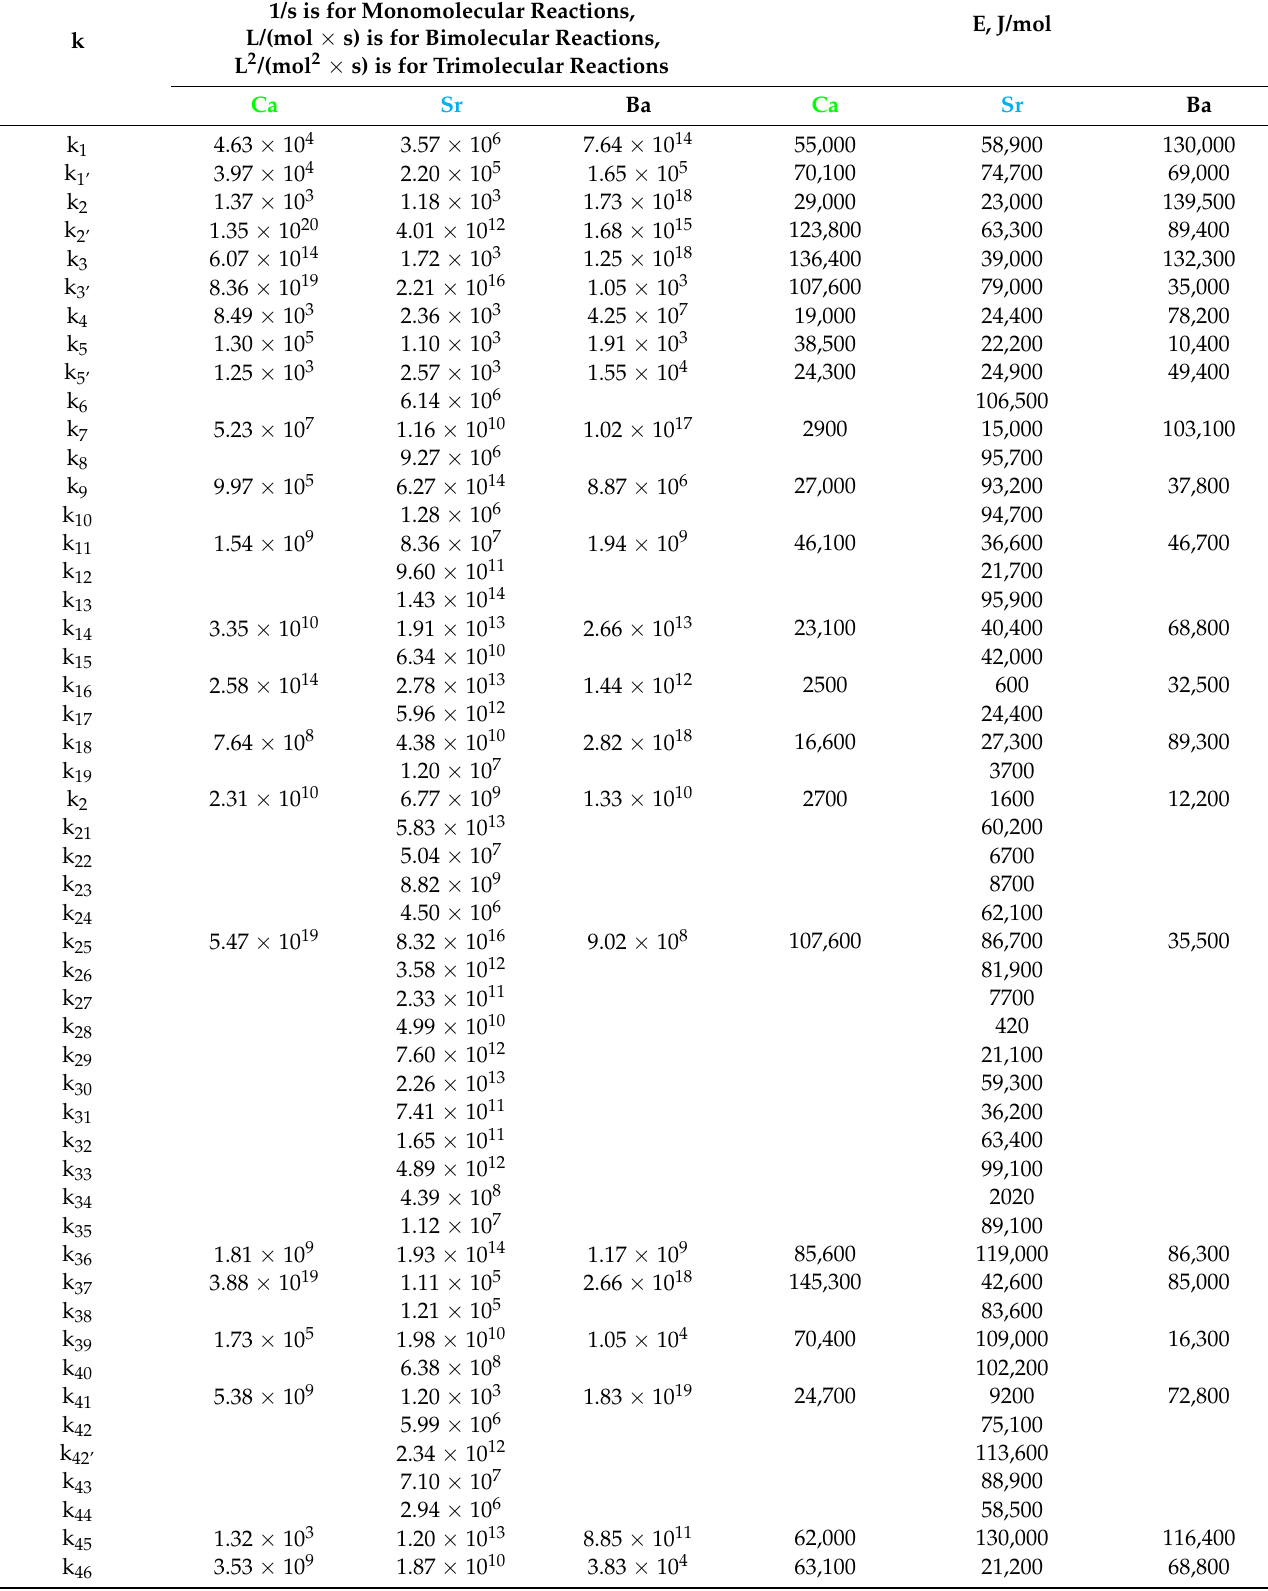
Table 2. Pre-exponential factor A and activation energy E in the Arrhenius equation k = Ae (R = 8.31 J/(mol K); T is temperature,